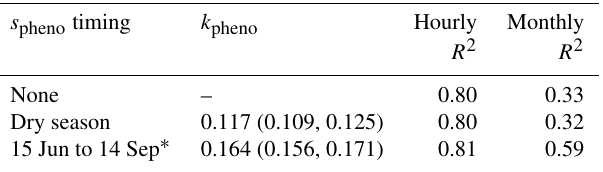
Table 2. k pheno parameter values (95% confidence intervals in parentheses) and hourly and monthly model fit associated with var- ious seasonal timings of the phenology factor variable s pheno